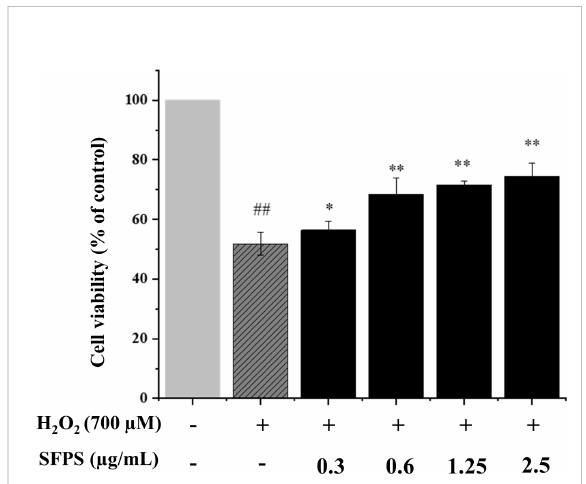
FIGURE 3 Protective effects of SFPS on H 2 O 2 -injured LO2 cells. LO2 cells were precultured with 0.3 to 2.5µg/ml SFPS for 12 h and then treated with 700µM H 2 O 2 for 3 h. Cell viability was measured by MTT assay. p < 0.01 (**) or p < 0.05 (*) indicates that the columns of H 2 O 2 group and SFPS groups are signi fi cantly different. p < 0.01 (##) indicates signi fi cant difference between the control group and the H 2 O 2